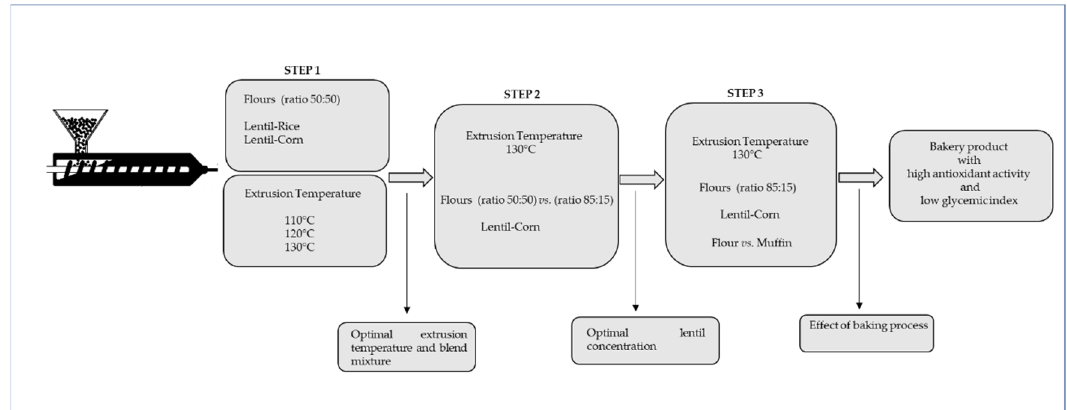
Figure 6. Experimental design.